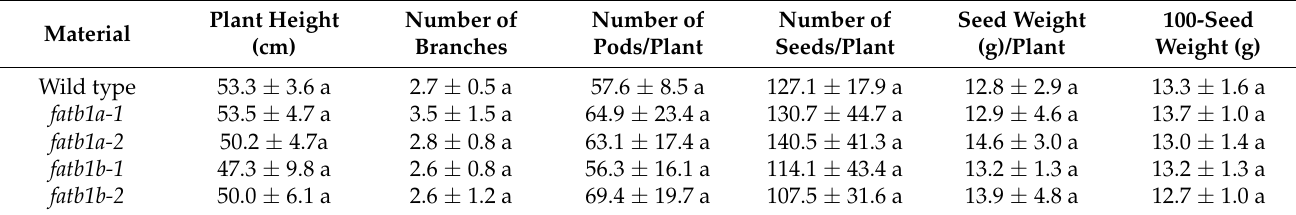
Table 3. Agronomic performance of the wild type, fatb1a , and fatb1b homozygous genetically modified material plants.